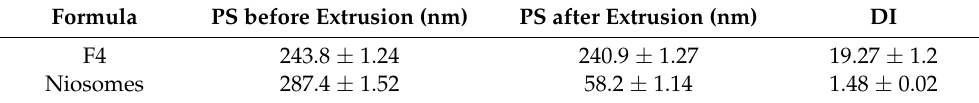
Table 7. Determination of the elasticity of EGCG-loaded SNVs and the corresponding niosomes. Formula